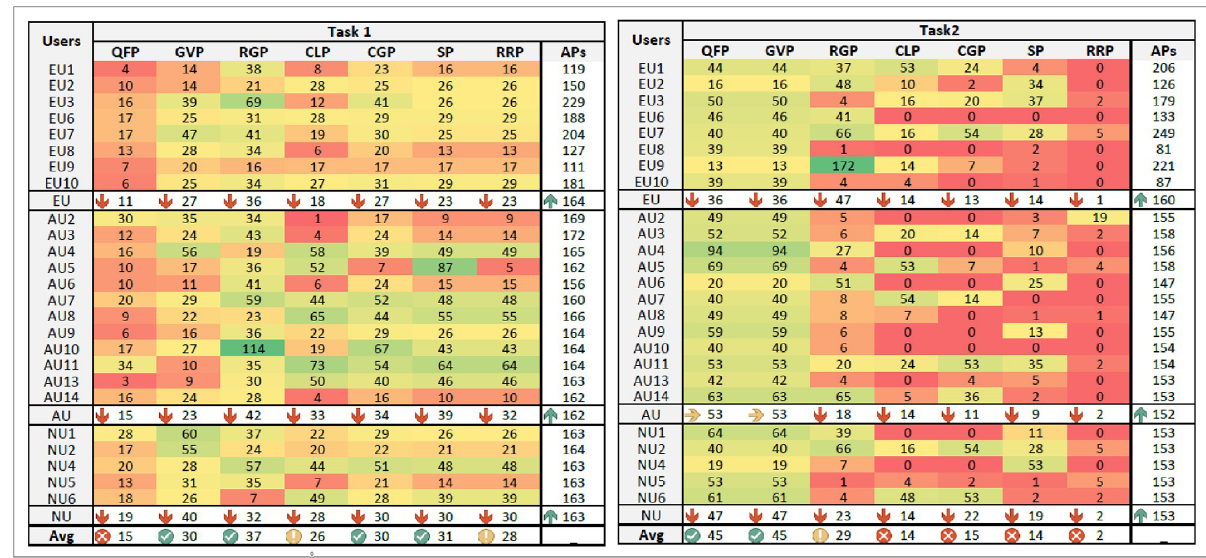
Fig 9. Respondents time-on-panel in the performance of exploration tasks ET 1 and ET 2 , (Where AP is the average precision of panels and Avg is the overall average).